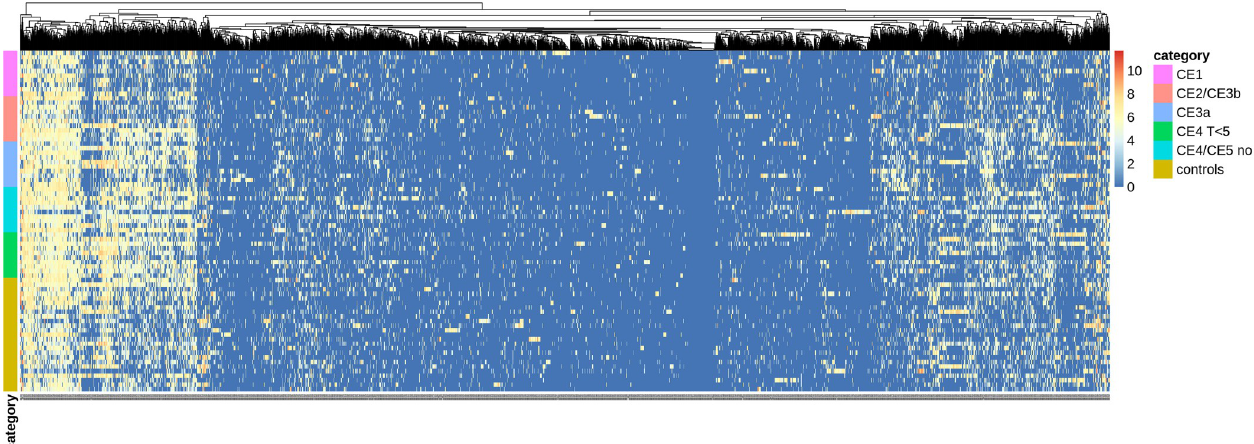
Fig 2. Heatmap summarizing the spot intensities of the peptide microarray for the selected peptides. Microarray reactivities to selected peptides by testing sera from the screening cohort, comprising 50 patients with CE and 25 controls with non-parasitic focal liver lesions. The heatmap depicts the distribution of the spot intensities from the peptide microarray according to the antigenic reaction. The blue and red colors indicate low and high antigenic response respectively. The clustering is generated from the heatmap and it groups the patients (y-axis) and the peptides (x-axis) according to the antigenic response from the microarray. Footnotes: CE, cystic